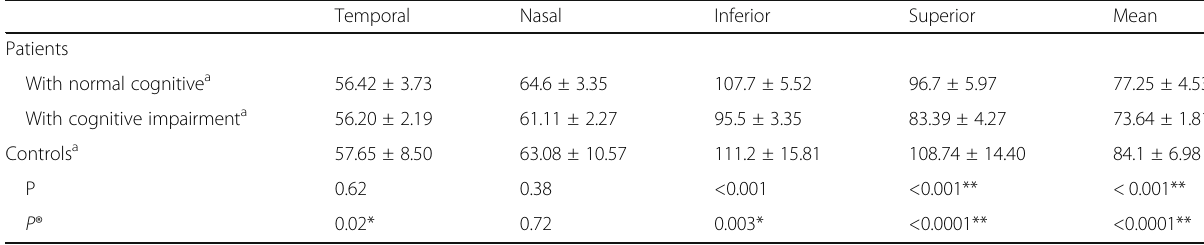
Table 2 RNFL thickness in the study populations